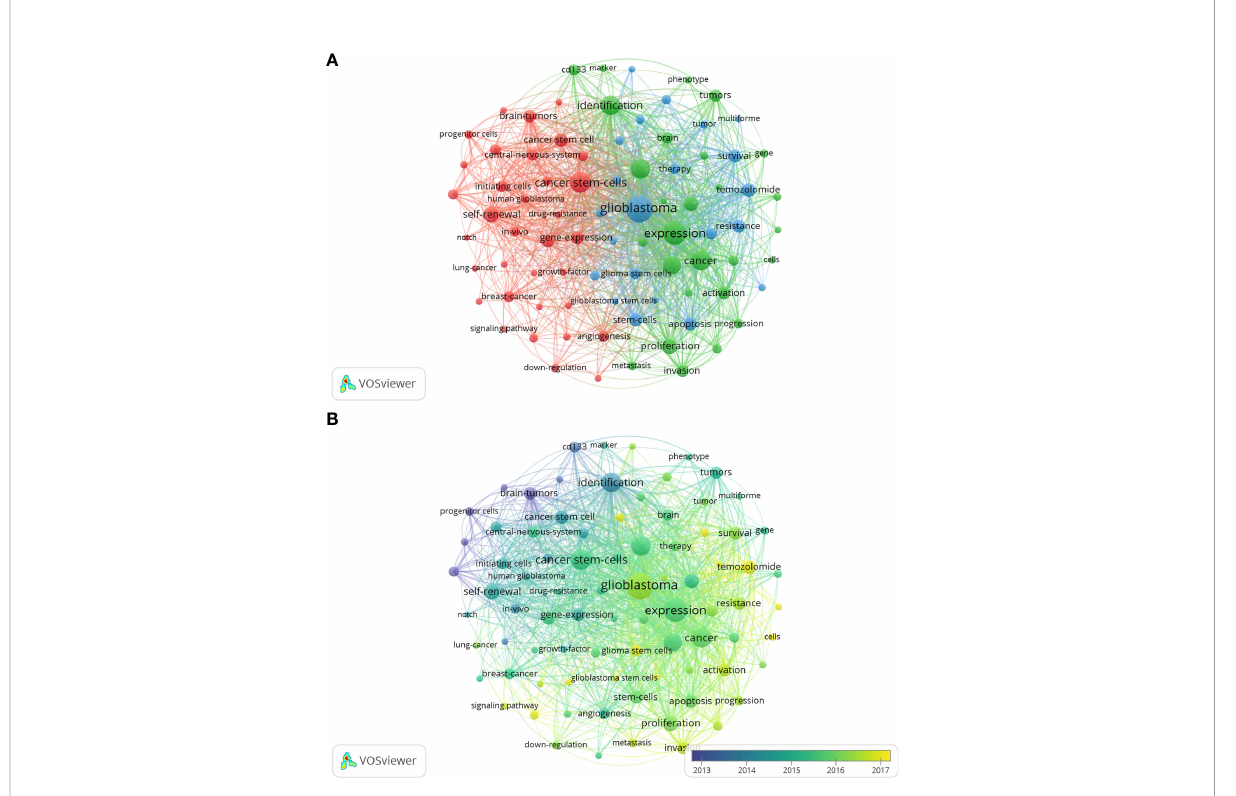
FIGURE 8 The network visualization map (A) and overlay visualization map (B) of keywords co-occurrence analysis on glioma stem cells research. Keywords with similar categories are gathered in a cluster. There are three clusters, including glioma stem cell properties ” (red nodes), “ cell biological properties ” (green nodes) and “ oncology therapy ” (blue